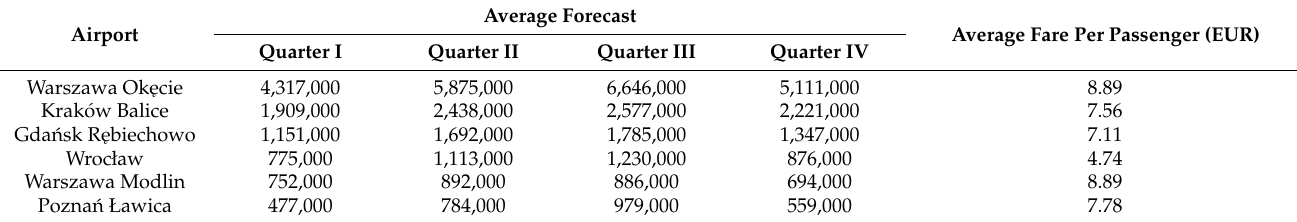
Table 9. Average values of forecasts for individual quarters of 2020 with the average amount of charges per passenger (in EUR).